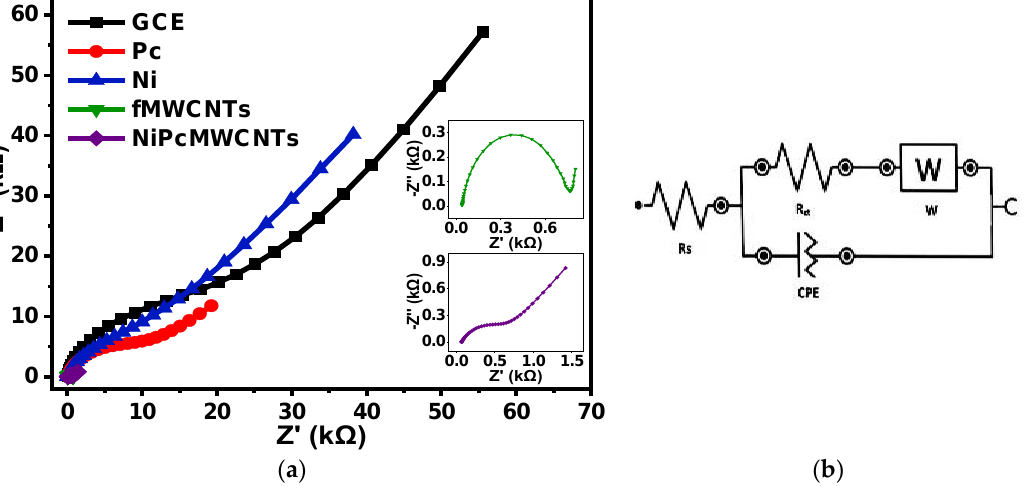
Figure 12. ( a ) Nyquist plots of GCE and modified electrodes in 0.1 M KBrO 3 produced in 0.1 M Na 2 SO 4 (pH 2). ( b ) represents the circuit used for the EIS data fitting.